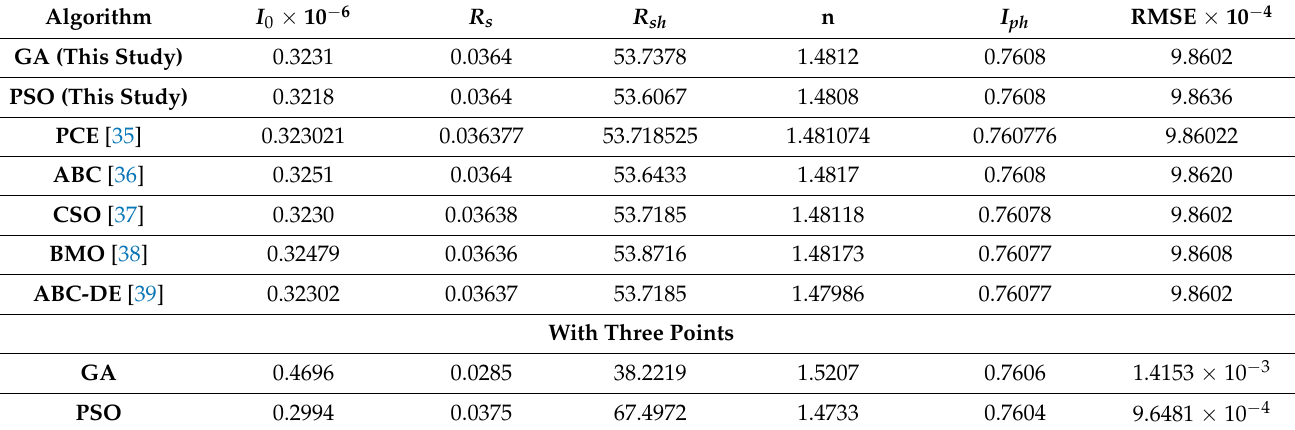
Table 3. Comparison of the results of different algorithms on RTC France cell.